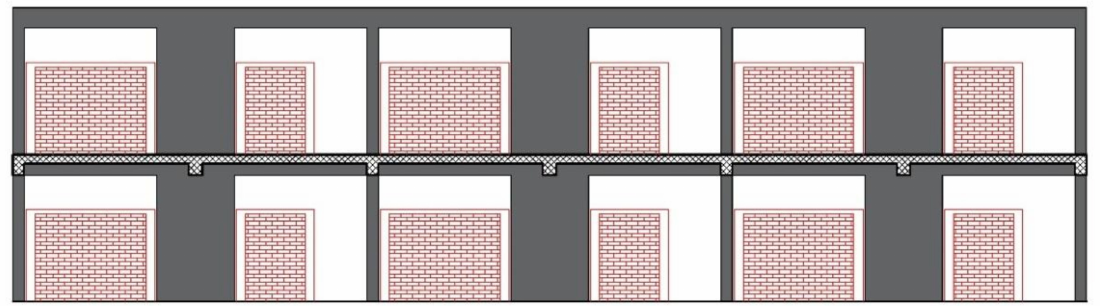
Figure 4. PREbuilding type: schematic view for the retrofitting intervention A 1